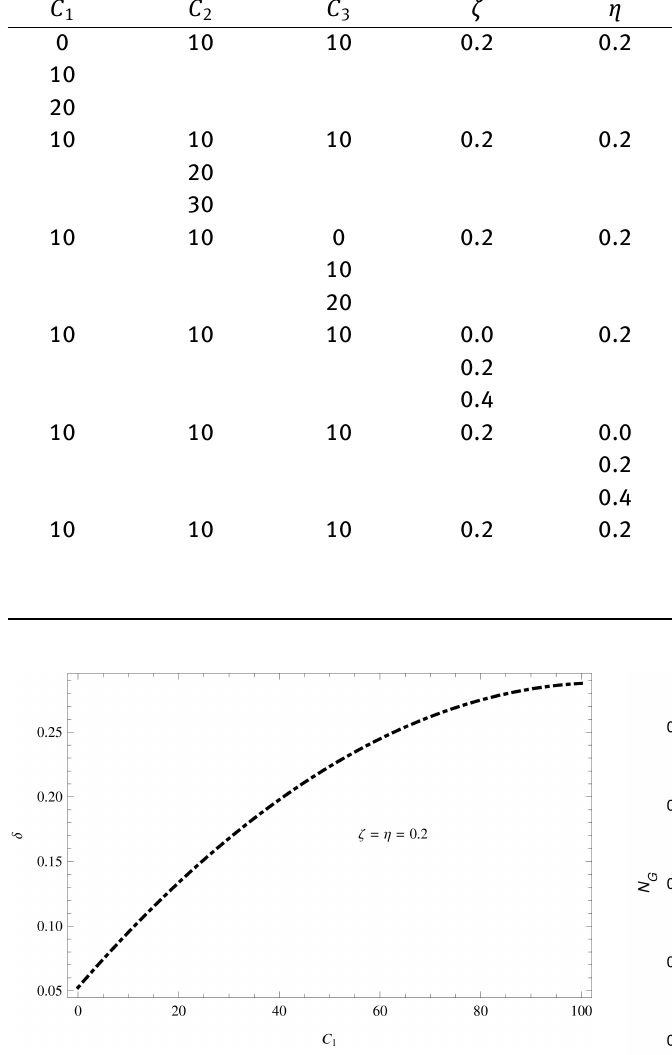
Figure 22: Effect of vortex viscosity parameter C 1 on boundary layer thickness δ keeping ζ = η = 0.2 , C 2 = C 3 = 10 , Br = 1 , Pr = 6.8 , Re = 2950 inatangentialdirection.Theradialskinfrictioncoefficient and Nusselt number decrease as the values of the microin- ertia density parameter C 3 increase, whereas skin friction coefficient increases in the tangential direction. The skin frictioncoefficientdecreasesforincreasingvaluesofradial slip parameter ζ , which allows more fluid to flow in a ra- dial direction. On the other hand, the tangential skin fric- tion and Nusselt number increase, which reduces the flow inatangentialdirection.Theincreasingeffectinthevalues of tangential slip parameter η decreases both the physical quantities like skin friction coefficient and Nusselt num-